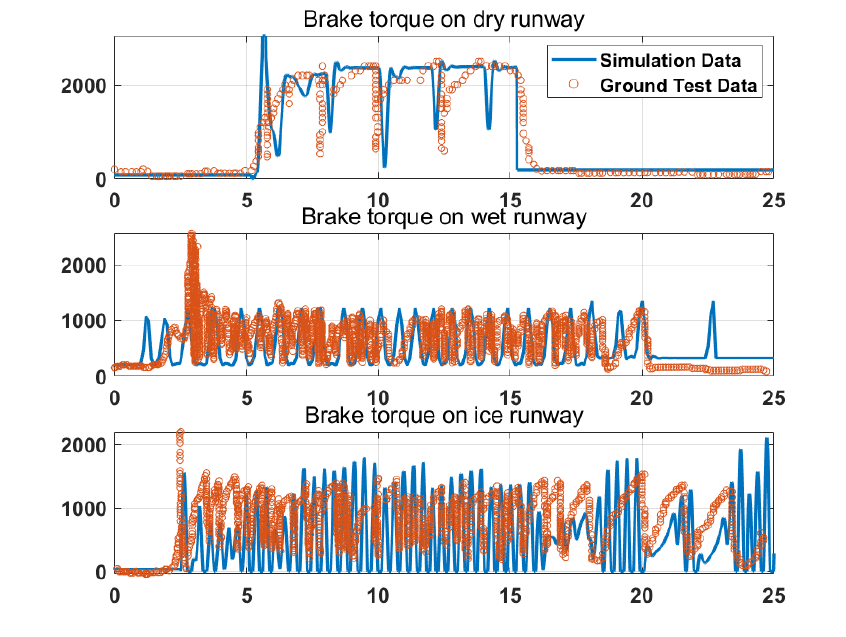
Figure 15. Comparison of ground test brake torque and simulation brake